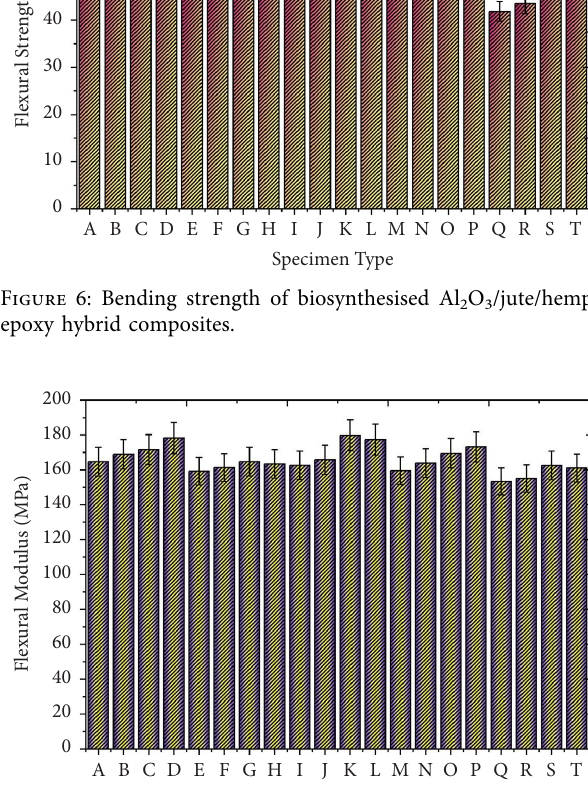
2 O 3 /jute/hemp/